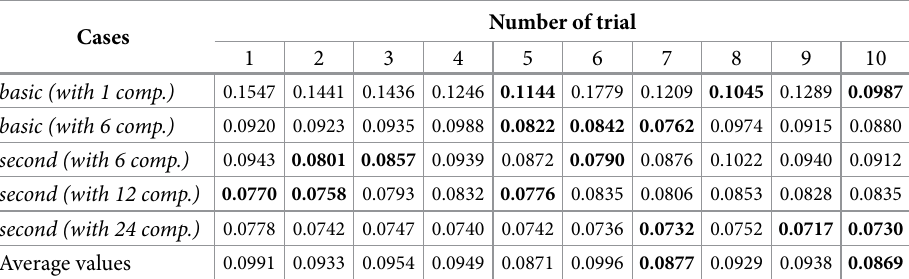
Table 1. Average values of the combined criterion obtained up till the end of each trial Number of trial Cases 1 2 3 10 basic (with 1